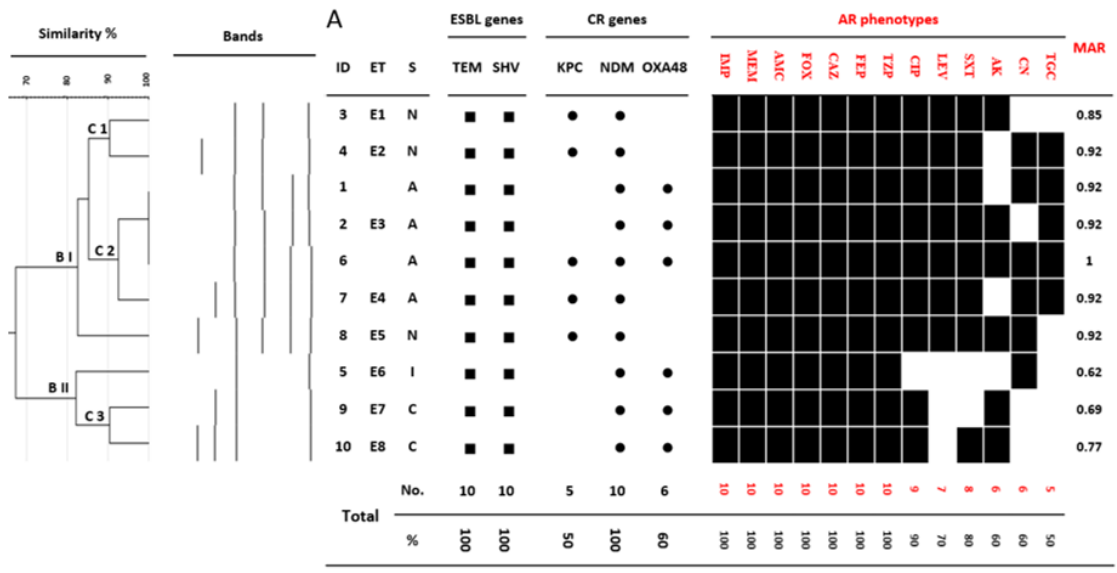
Figure 4. ERIC typing dendrogram of K. pneumoniae isolates and their associated genetic and phenotypic antimicrobial resistance patterns. The 10 tested isolates were classified into two branches (BI and BII) and three clades (C 1-3) with a total of 8 distinct ERIC genotypes (ET: ERIC type